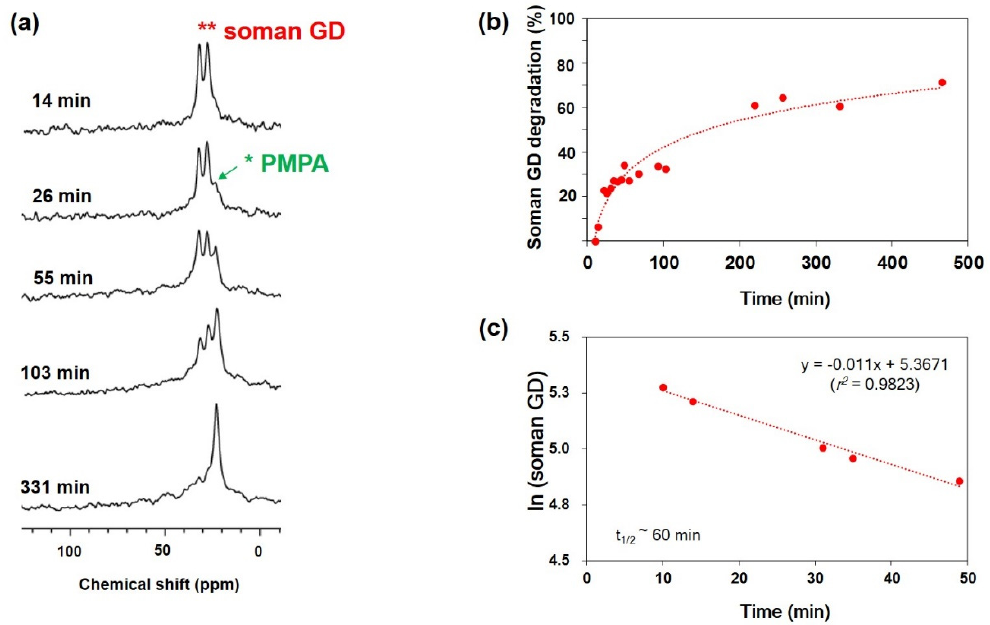
Figure 5. ( a ) 31 P SS-MAS NMR spectra for the reaction mixture of Zr(OH) 4 / GO nanocomposite and soman (GD), showing the presence of soman (GD) (27.3, 31.6 ppm) and PMPA (24.4 ppm), ( b ) reaction profile of catalytic degradation of soman (GD) upon exposure to Zr(OH) 4 / GO nanocomposite in neat at 25 ℃ soman (GD): 5 μ L (0.028 mmol), sample weight: 93.8 mg, and ( c ) the plot of the soman (GD) loss in Zr(OH) 4 / GO nanocomposite, showing linearity of the curve with following pseudo-first-order and an estimated half-life of 60